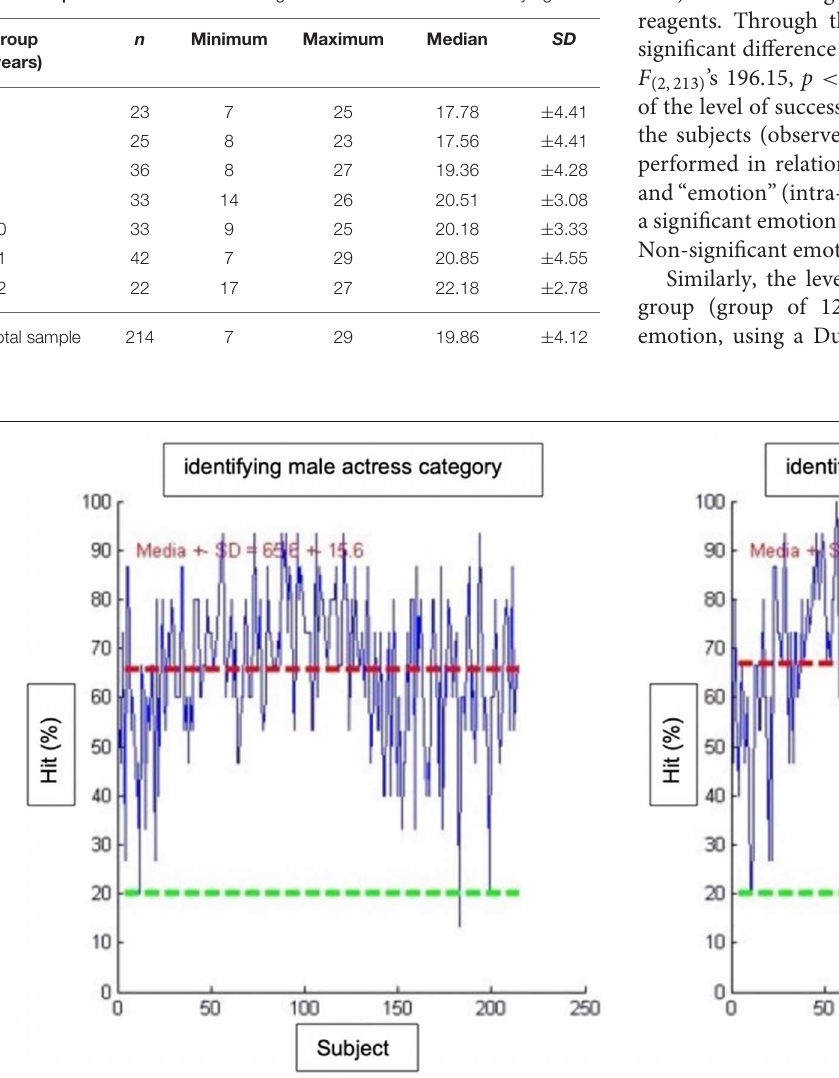
FIGURE 5 | Percentages of correct answers according to gender of the